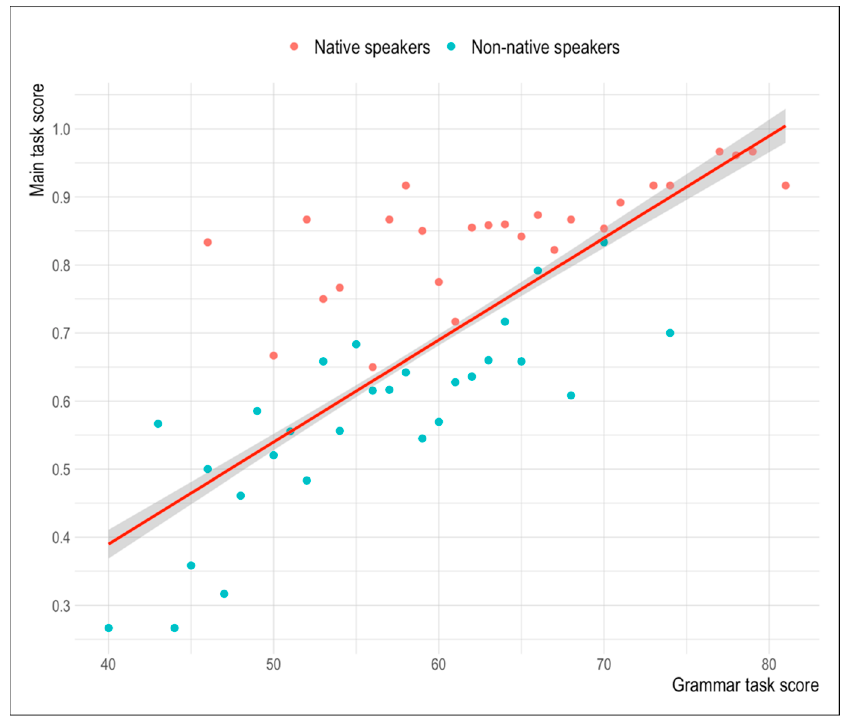
Figure 9. Relationship between the scores of the main task and the grammar task by native and non-native participants .